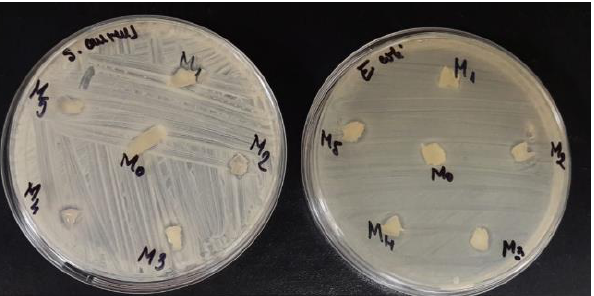
Figure 10. M o = PVA/XG-100/0; M 1 = PVA/XG-90/10; M 2 = PVA/XG-80/20; M 3 = PVA/XG-70/30; M 4 = PVA/XG-60/40; M 5 = PVA/XG-50/50.